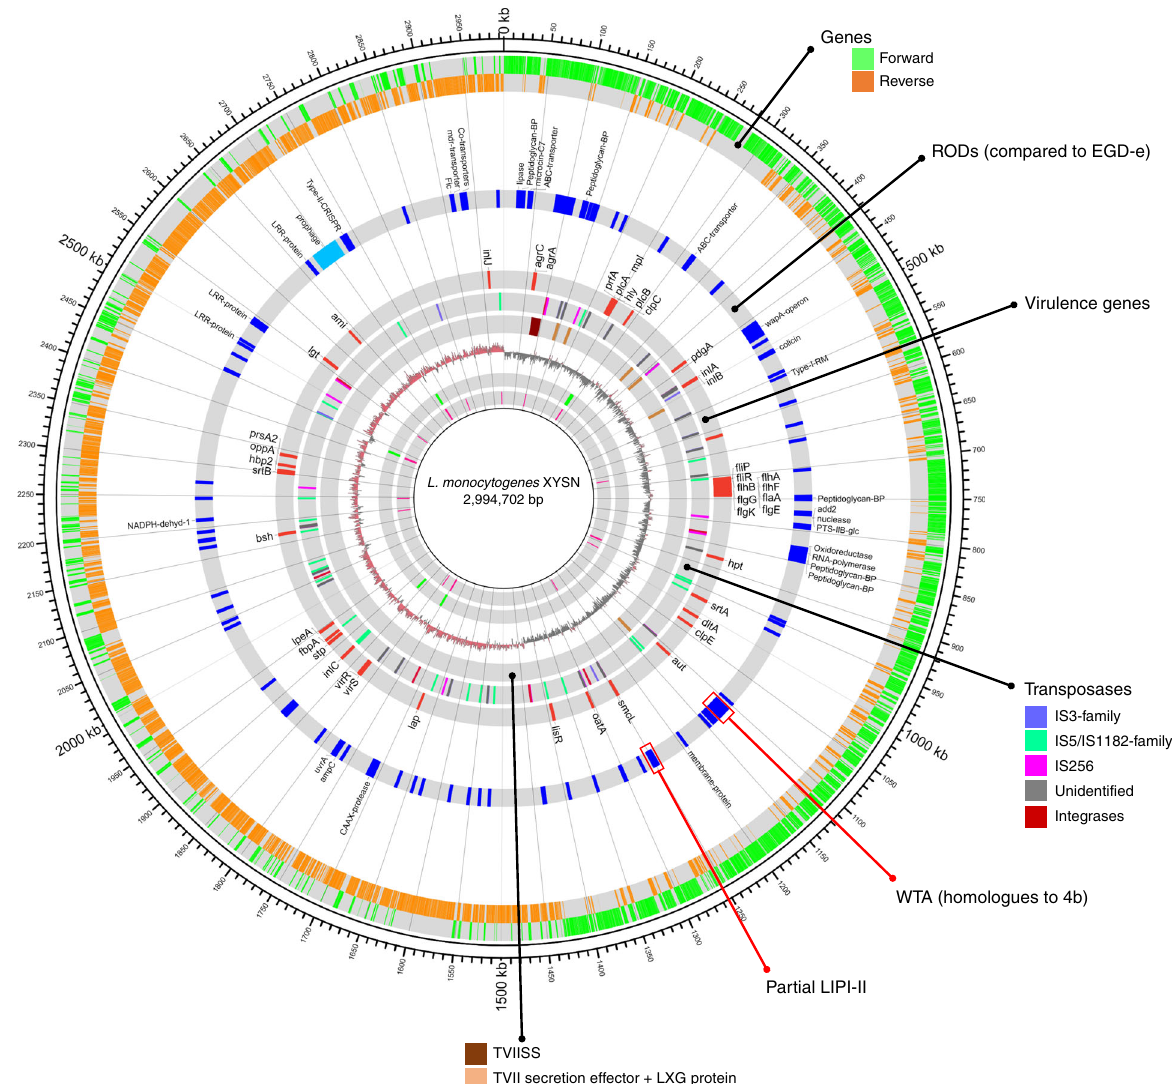
Fig. 3 Genomic features of L . monocytogenes HSL-II isolate XYSN. The image depicts the closed genome of the L . monocytogenes HSL-II isolate XYSN. The innermost to outermost (gray) circles indicate the respective locations of tRNA, rRNA, GC-skew, T7SS, transposases, virulence genes, chromosomal region of differences (ROD) in XYSN compared with the EGD-e, forward – reverse genes, and an ideogram indexing base pairs. The fi gure was constructed